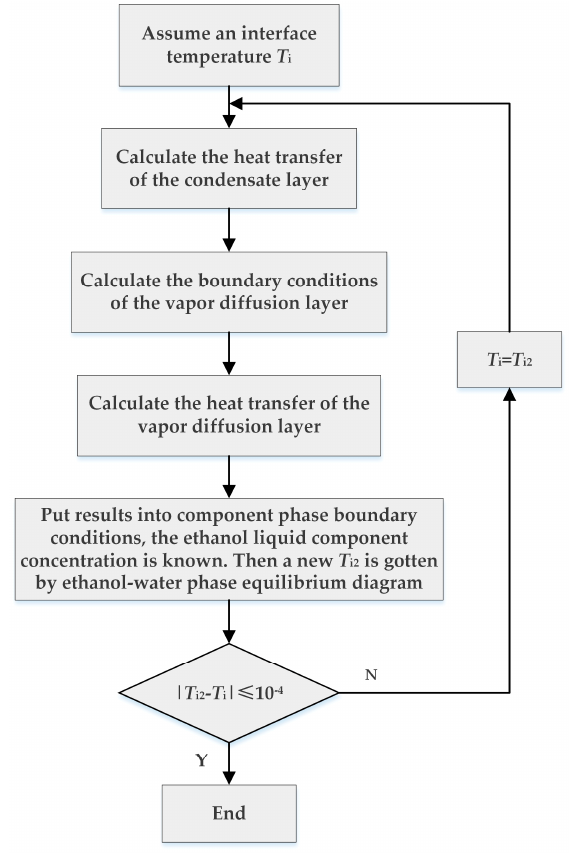
Figure 2. Calculation process of the proposed model.